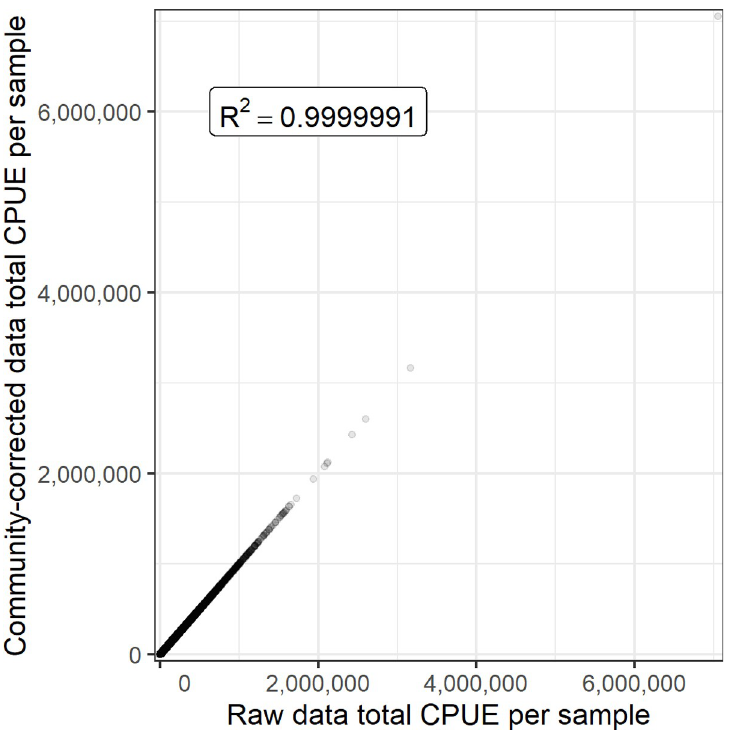
Fig 6. Relationship between the raw CPUE in the source datasets and the CPUE after fixes to taxonomic resolution were applied (Fig 5A). The total CPUE per sample was almost exactly identical in both cases, as indicated by the R 2 = 0.999999. Differences resulted from taxa that were counted in some surveys but discarded in others, since these taxa are removed in the process to resolve the taxonomic resolution. When these problematic taxa were removed from both datasets, total CPUE per sample was exactly identical in all